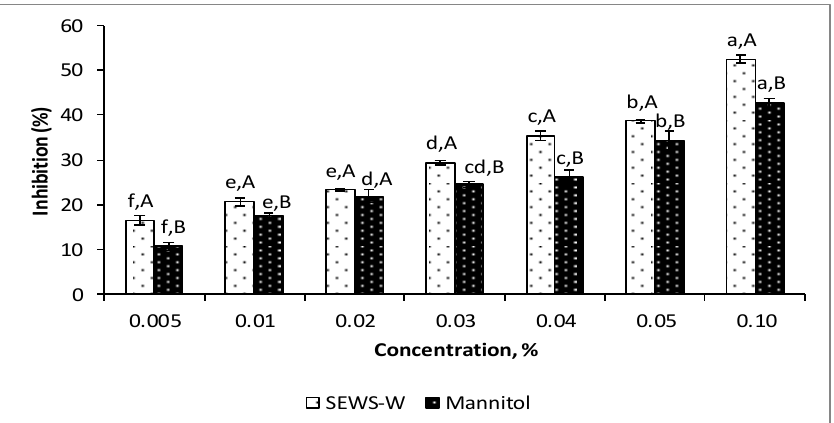
Figure 3. Hydroxyl radical scavenging activity of sunflower meal ethanol-wash solute dissolved in water. a–f Means of one sample with different concentrations without a common letter differ signifi- cantly ( p < 0.05). A,B Means of the two samples with the same concentration without a common letter differ significantly ( p < 0.05). Standard deviations (SD) of the means varied from 0.27 to 1.98.